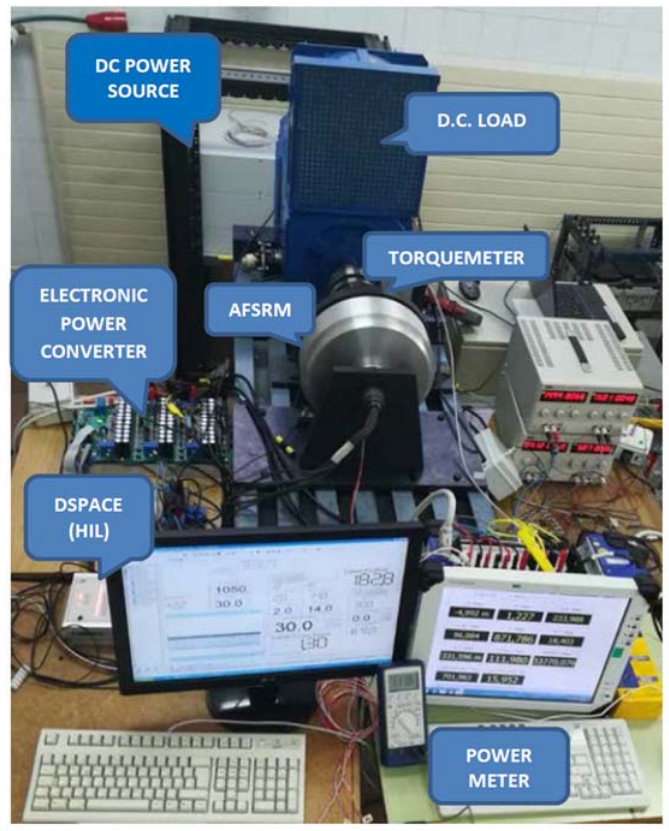
Figure 17. AFSRM drive test rig.